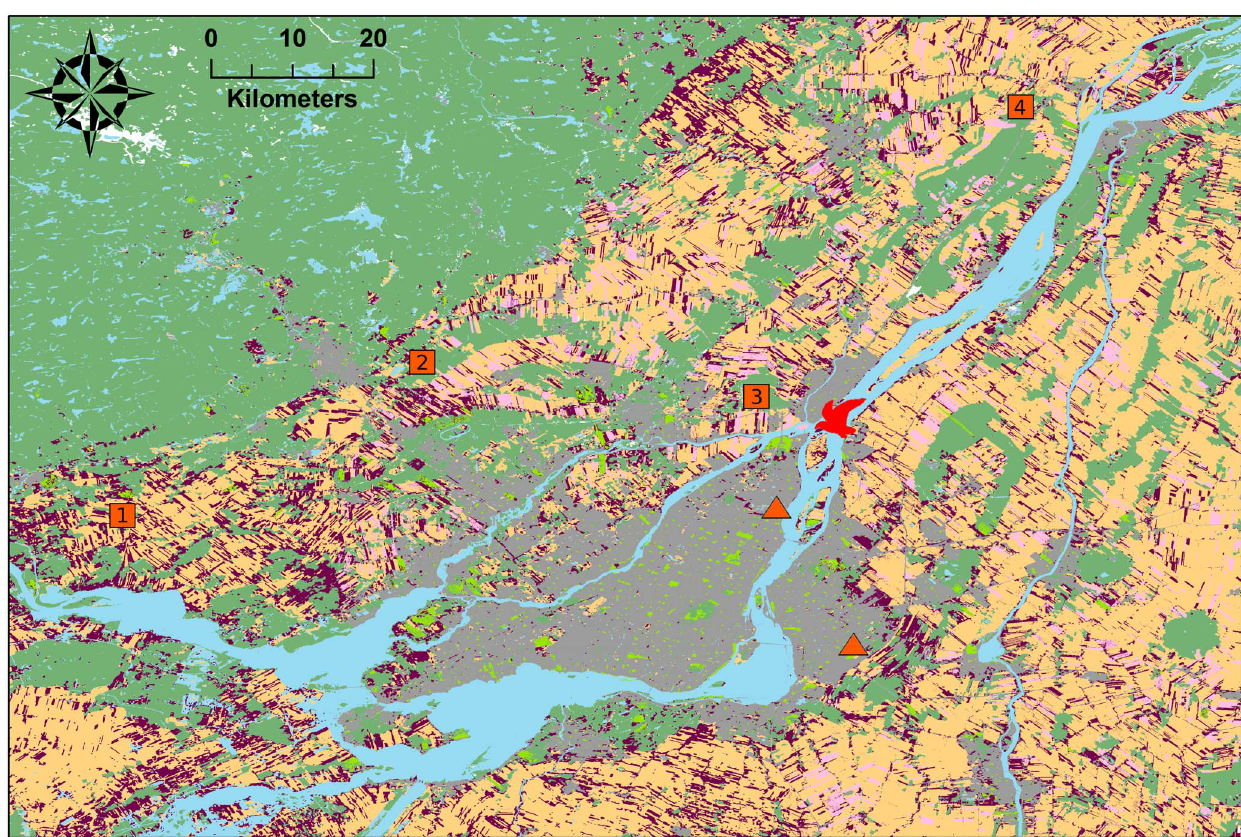
Figure 1. Map of the study area. Land cover types include water (blue), urban areas (gray), intensive cultures (mango), extensive cultures (purple), unidentified cultures (rose), lawns (olive green), and woodlots (dark green). Numbers in squares indicate landfill locations (1- Lachute, 2- Ste-Sophie, 3- Terrebonne, 4- St-Thomas), red triangles indicate transhipment site locations, and the bird pictogram indicates the location of the Deslauriers Island Ring-billed gull colony. doi:10.1371/journal.pone.0102162.g001 foraging in their main feeding habitats. In agricultural habitats, we respectively). We tallied the number of birds in each flock and surveyed a 50-km roadside transect on each shore of the St. performed an instantaneous scan sampling to determine the Lawrence River ( N =13 and 21 surveys in 2009 and 2010, proportion of birds foraging (head down below the horizontal or